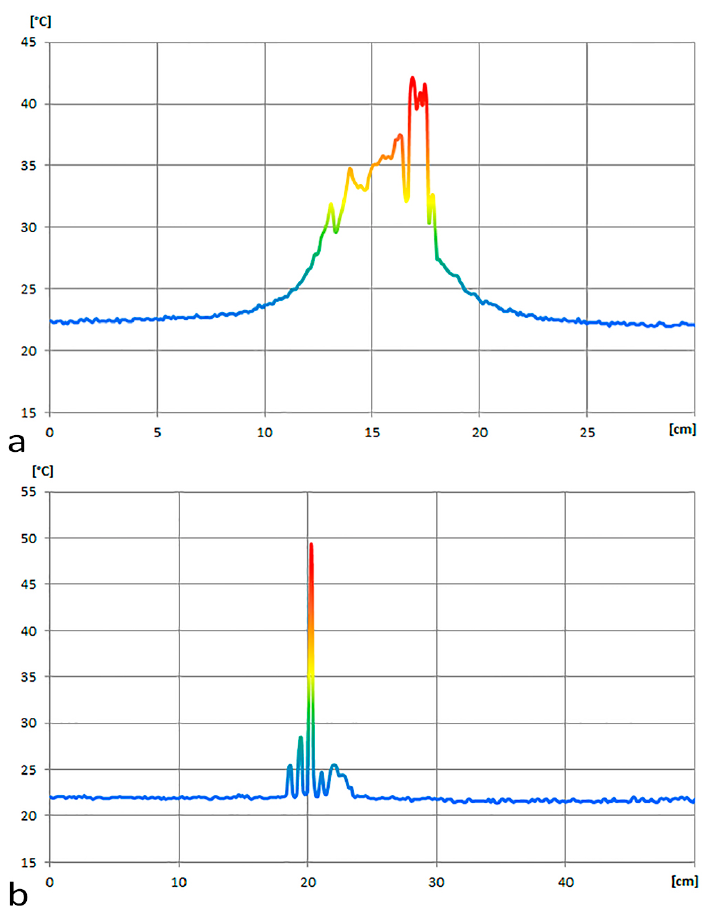
Figure 4. Temperature distribution: ( a ) Profile 1; and ( b ) Profile 2.